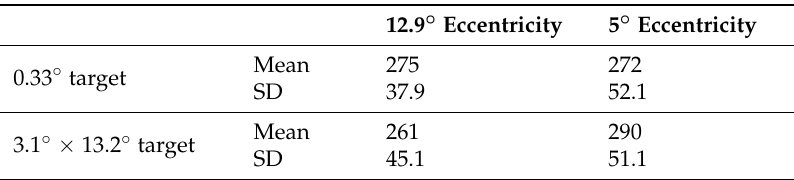
Table 1. Means and standard deviations of refixation latencies (in ms) towards stimuli of different sizes and